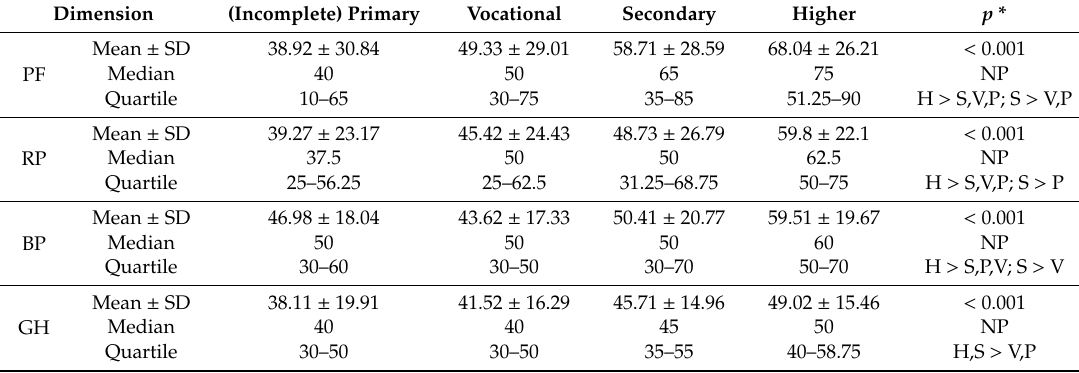
Table 6. Quality of respondents’ life in individual dimensions versus their education.